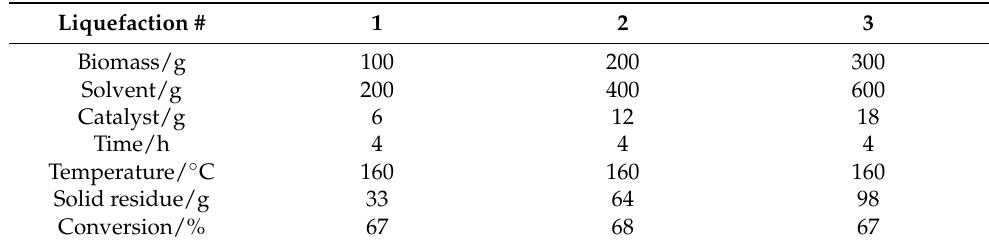
Table 2. Experimental conditions and degree of conversion of the solvolysis liquefaction of ground cork granules biomass.